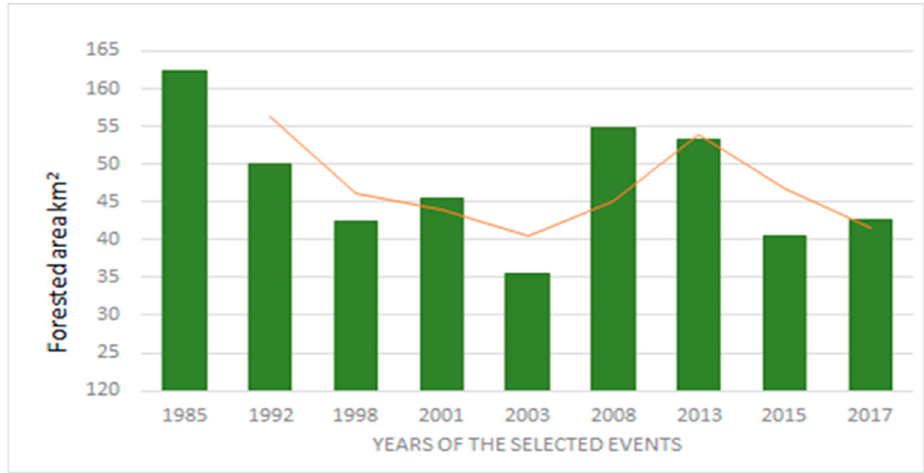
Figure 11. The evolution of the forested area.